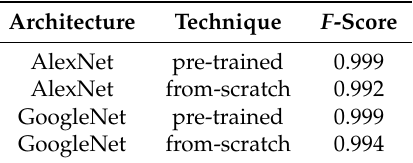
Table 3. Experiment results.